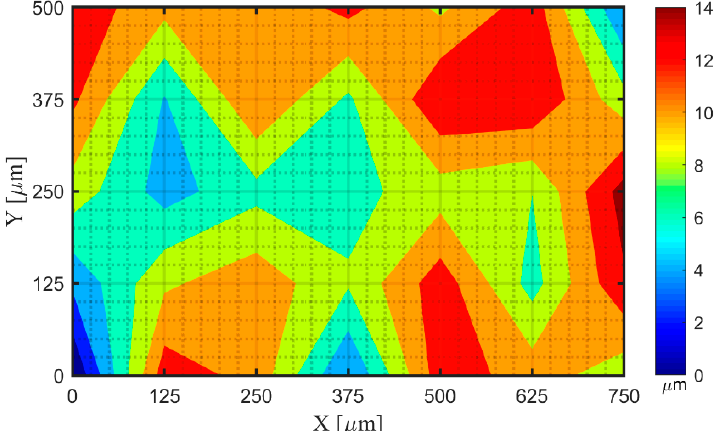
Figure 15. Contour of the errors between the certified and measured points.